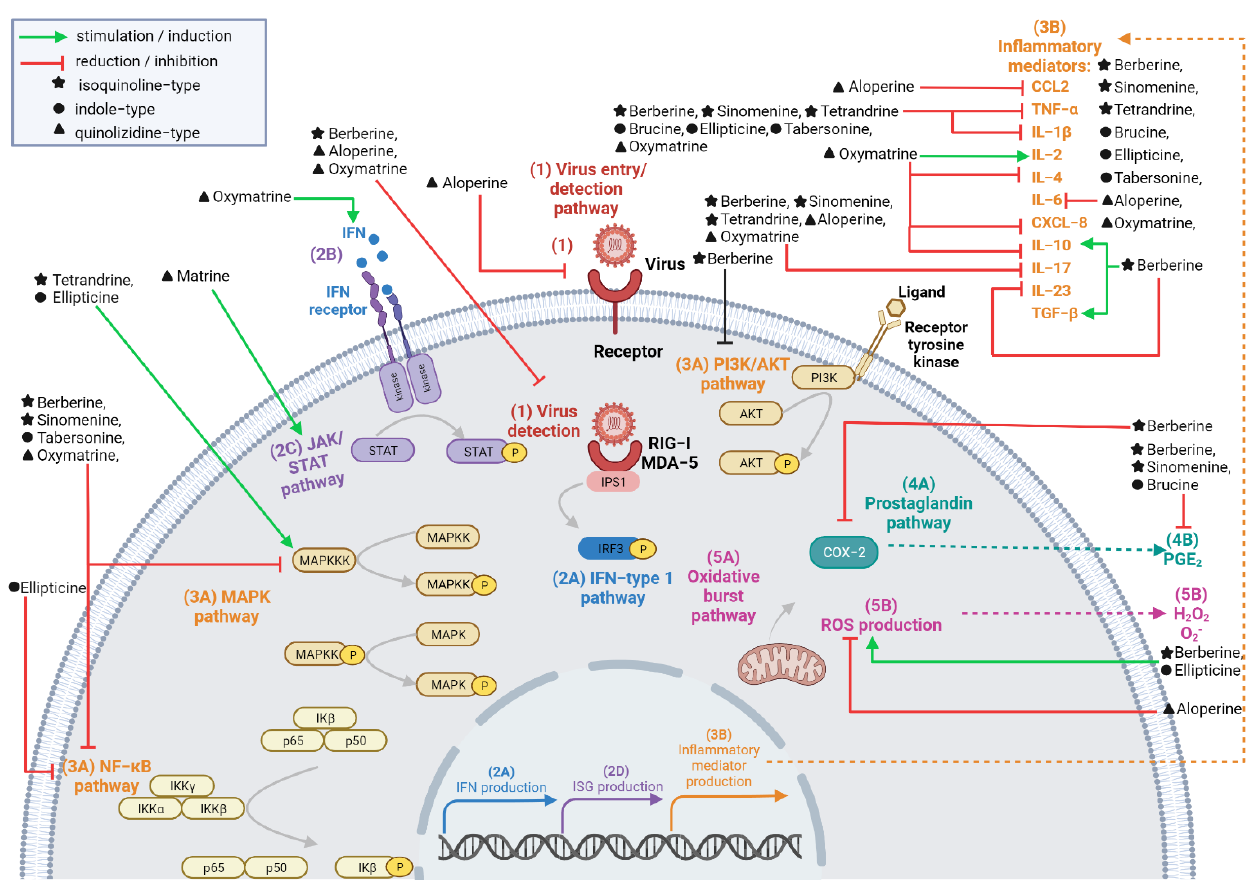
Figure 3. Effects of the selected alkaloids on virus detection (1), antiviral and/or inflammatory signaling pathways (2A), (2C), (3A), (4A) or (5A) and mediators (2A), (2B), (2D), (3B), (4B) and (5B). The figure was created using biorender.com